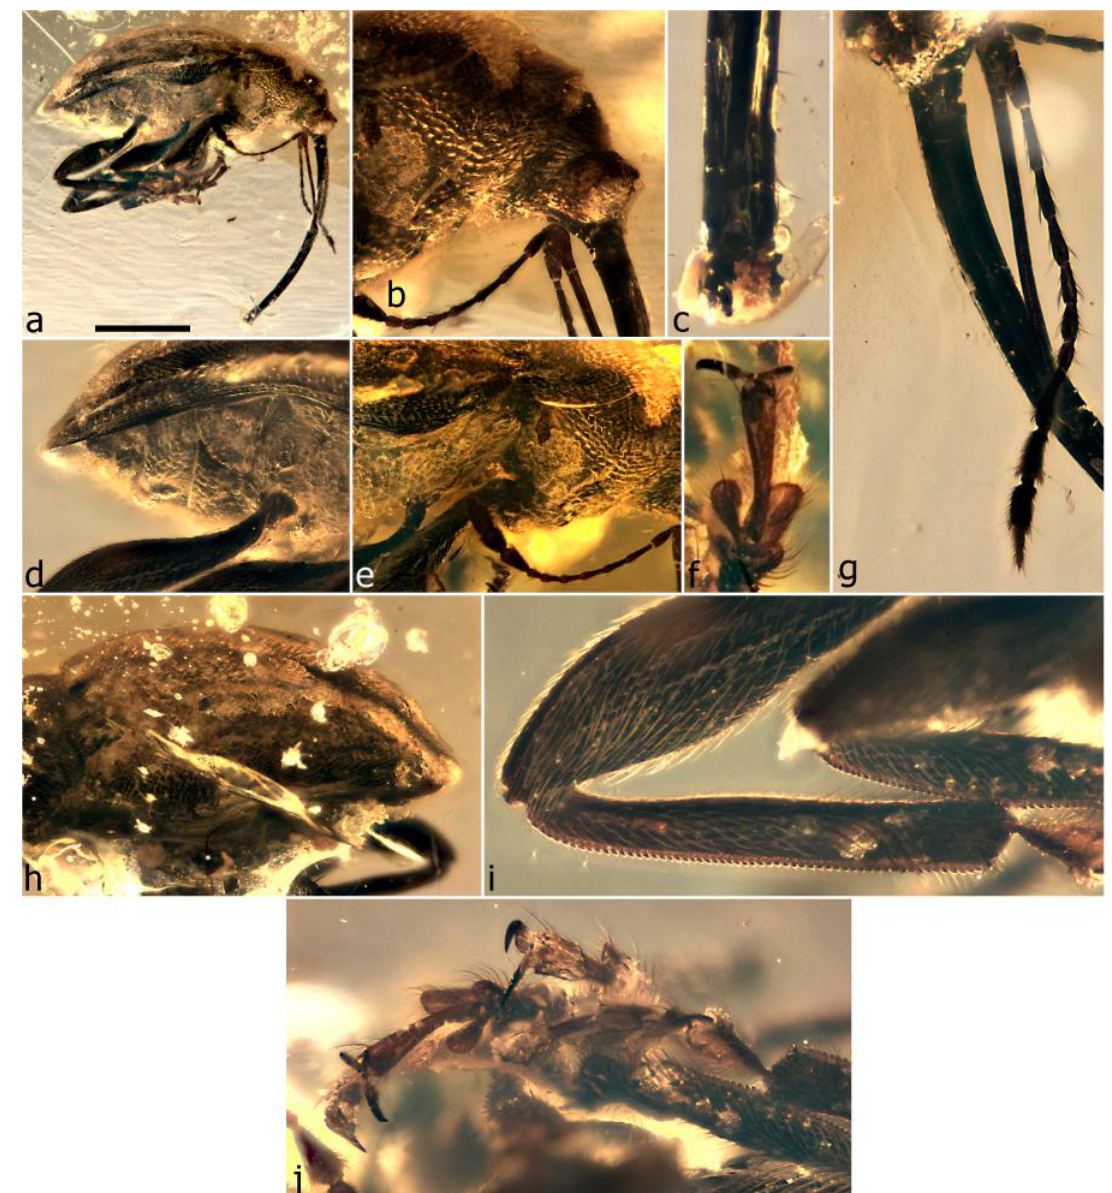
Figure 58. Mekorhamphus beatae sp. n., holotype. Habitus, right lateral ( a ); head and prothorax, right lateral ( b ); apex of rostrum and mandibles, dorsal ( c ); ventrites, right lateral ( d ); prothorax and anterior pterothorax, right lateral ( e ); tarsites 2–5, dorsal ( f ); left antenna, left lateral ( g ); elytra, left lateral ( h ); right metatibia (outer side) showing crenulation ( i ); tarsi ( j ). Scale bars: 1.0 mm (a).